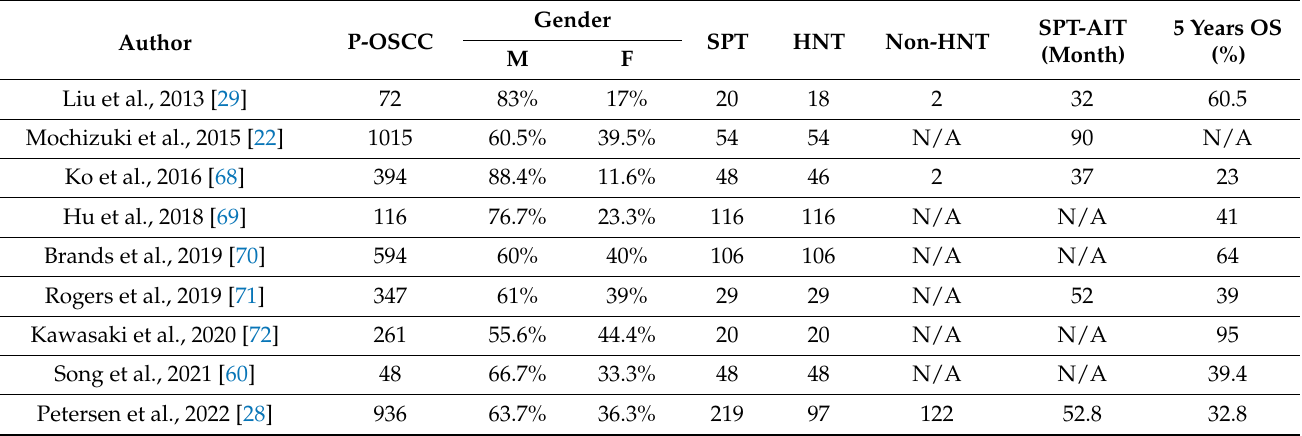
Table 1. Overview of screened literature reporting Second Primary Tumors (SPTs) in Primary Oral Squamous Cell Carcinoma